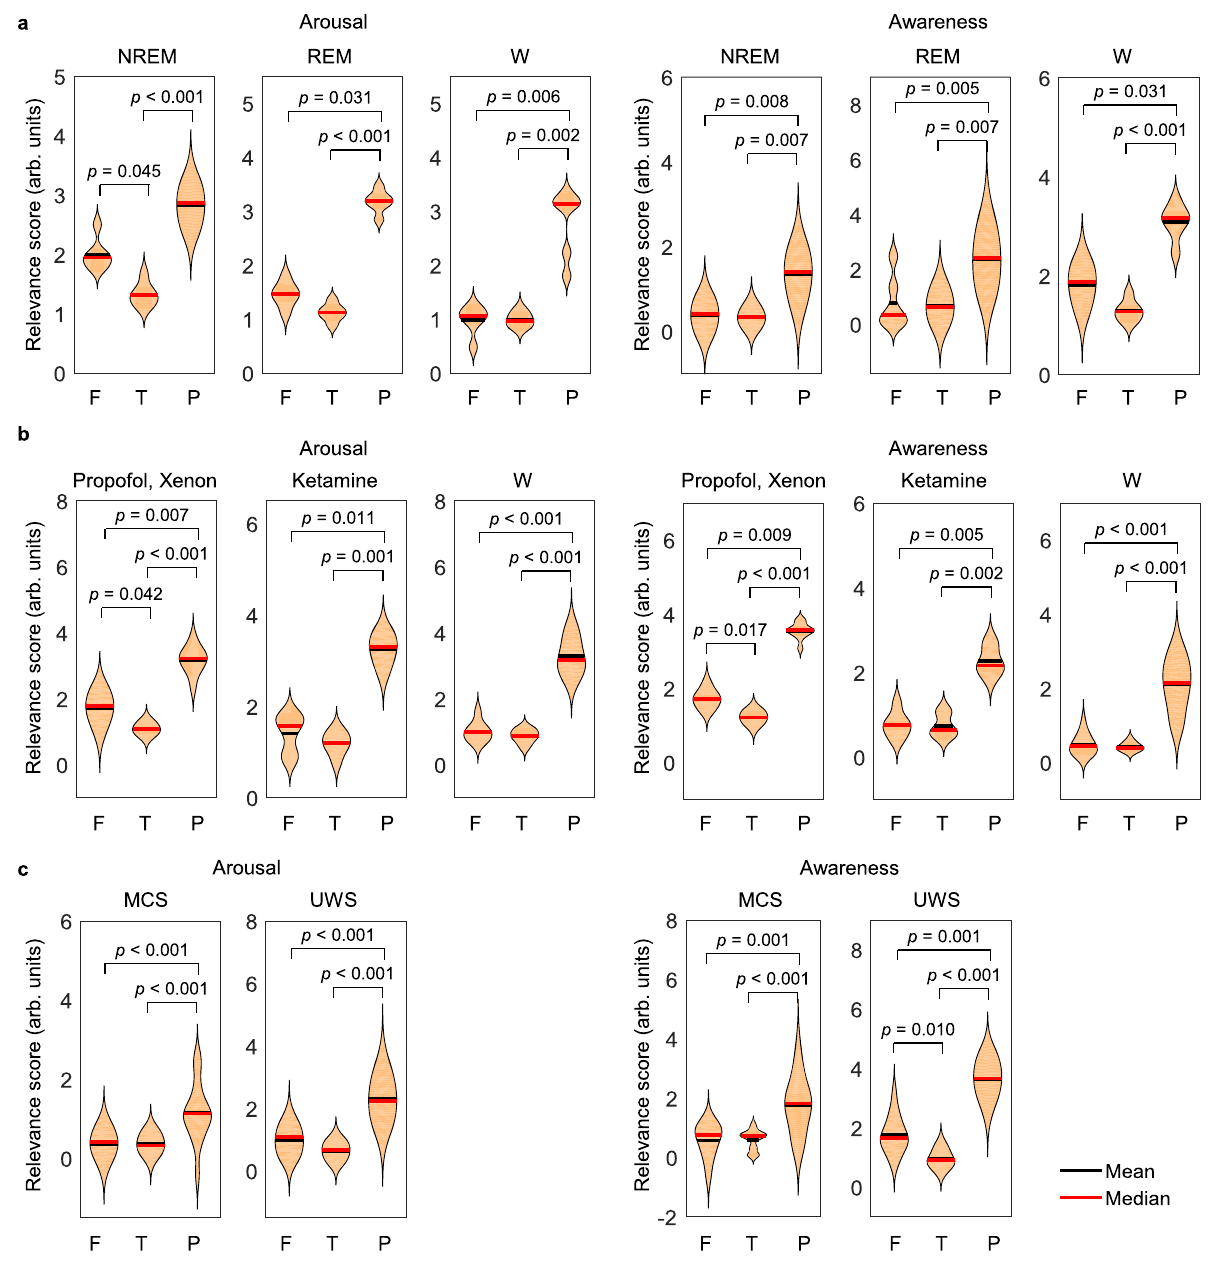
Fig. 7 Relevance scores from LRP in TMS – EEG. a Sleep and normal wakefulness, b anesthesia and wake, and c patients with DoC. The violin plots depict the average relevance scores over the frontal, temporal, and parietal regions in all participants. The exact p -value corresponding to the signi fi cance level was shown using two-sided multiple t -tests with Fisher ’ s least signi fi cant differences method for multiple comparisons. [arb. units] denotes an arbitrary unit. F frontal region, T temporal region, P parietal